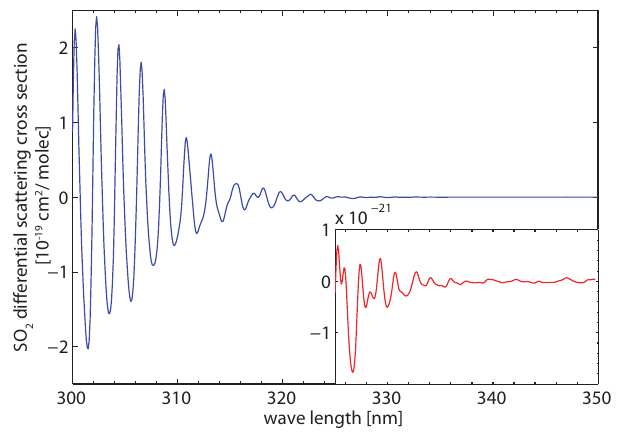
Fig. 5. A high pass filtered SO 2 cross section at the same optical resolution as the QE65000 spectrograph used with the centre looking telescope. The inserted graph displays the respective part of the SO 2 cross section magnified by a factor of 100.